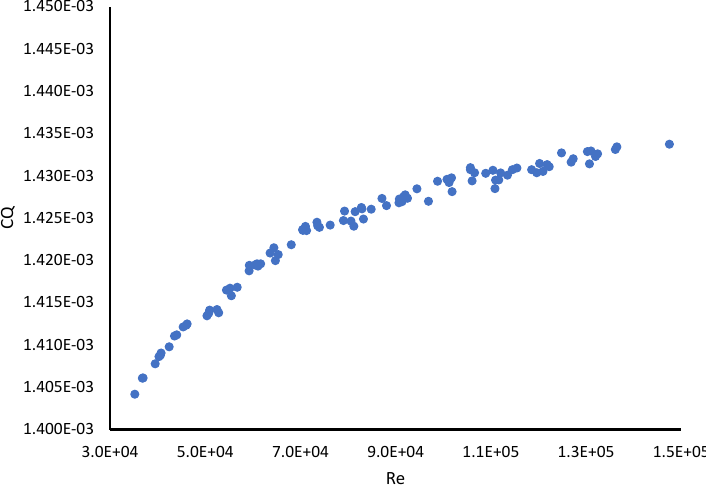
Figure 6. Computational results for torque coefficient as a function of